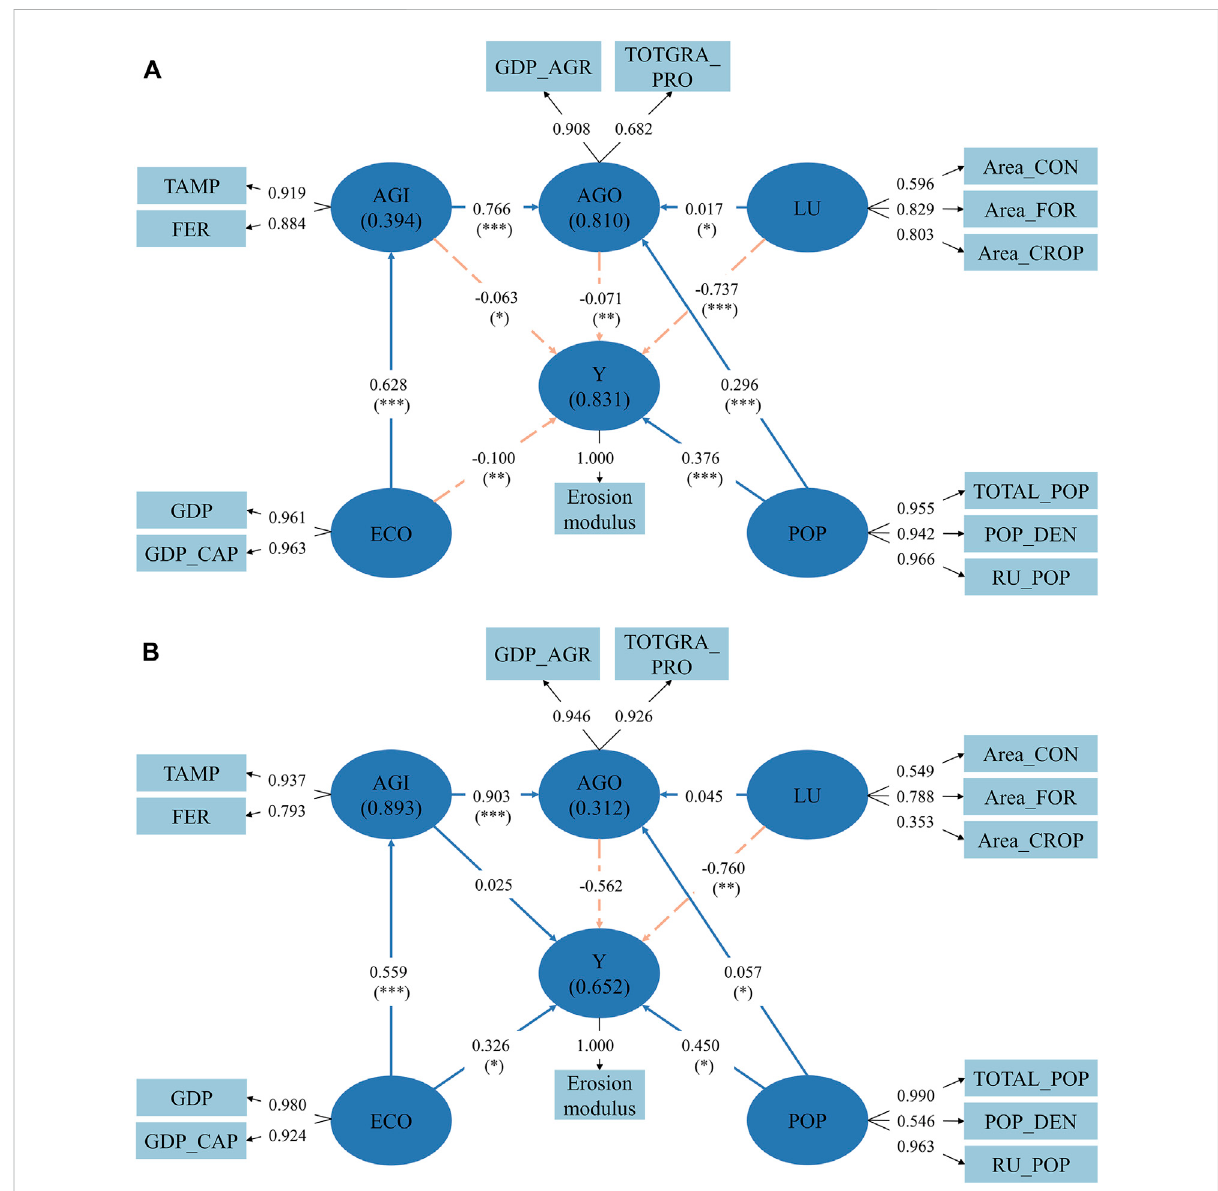
FIGURE 5 Partial least squares structural equation model showing the relationship between socio-economic factors and soil erosion of Yan ’ an (A) and Qingyang (B) . Abbreviations are de fi ned in Table 1. The ellipses represent latent variables and the rectangles represent manifest variables. The lines between latent variables are paths, and the lines from latentvariableto manifest variable are loadings. Orange lines indicate negative correlation and blue lines indicate positive correlation. p , pp and ppp indicate signi fi cance levels of p < 0.05, 0.01, and 0.001,